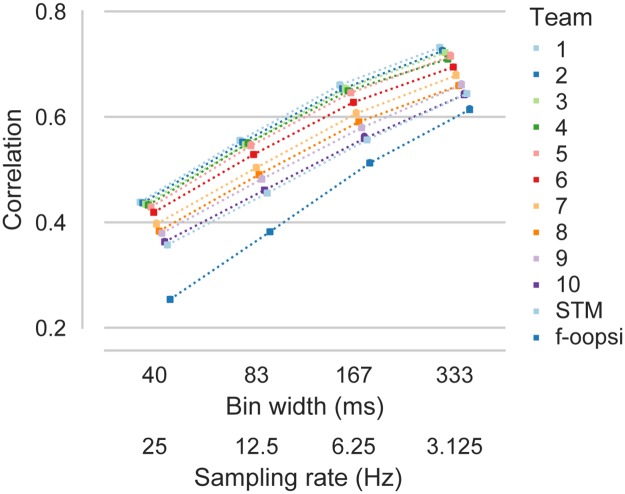
Temporal resolution does not change the ranking of algorithms.Mean correlation between inferred and true spike rates evaluated at different temporal resolution/sampling rate on all N = 32 cells in the test set. Colors indicate different algorithms. Colored dots are offset and connected for better visibility. STM: Spike-triggered mixture model [15]; f-oopsi: fast non-negative deconvolution [9].